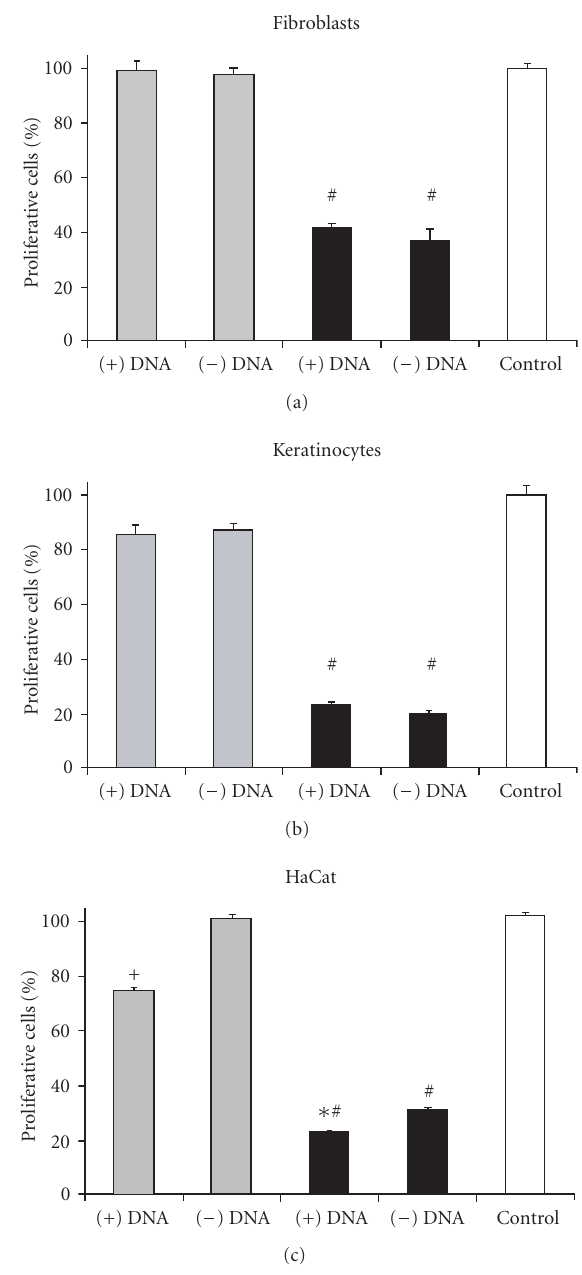
Figure 4: Proliferation . MTT test was performed to analyze the cy- totoxic side e ff ects of lipofection (striped) and nucleofection tech- niques (black). The additional cytotoxic e ff ect of plasmid DNA was determined to distinguish these techniques further. Proliferation control was set at 100%. #: ( P < . 05) nucleofection versus lipo- : ( P < . 05) nucleofection (+) DNA versus nucleofection fection; (cid:3) ) DNA; +: ( P < . 05) lipofection (+) DNA versus lipofection ( ) ( (cid:4) (cid:4) DNA. Data are shown as mean (cid:0)